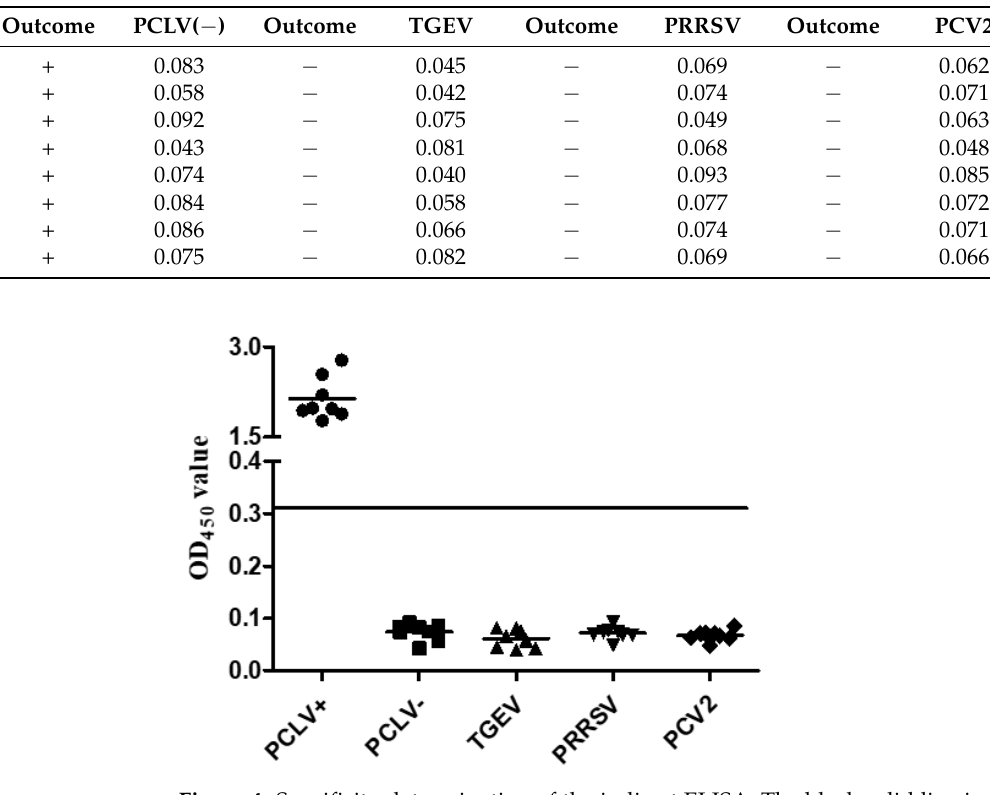
Figure 4. Specificity determination of the indirect ELISA. The black solid line indicates the OD 450 cut-off value (0.304).